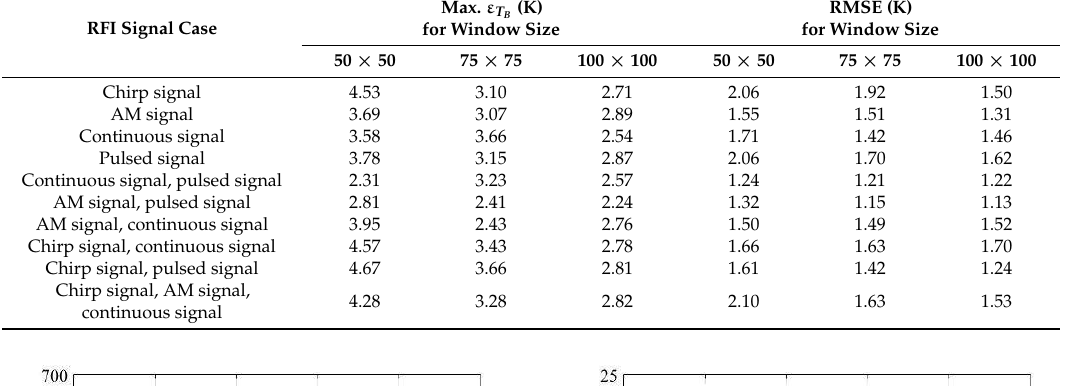
Table 2. Maximum error of the retrieved brightness temperature (K) for different cases of RFI signals with the RFI level up to ~100 K. RFI Signal Case